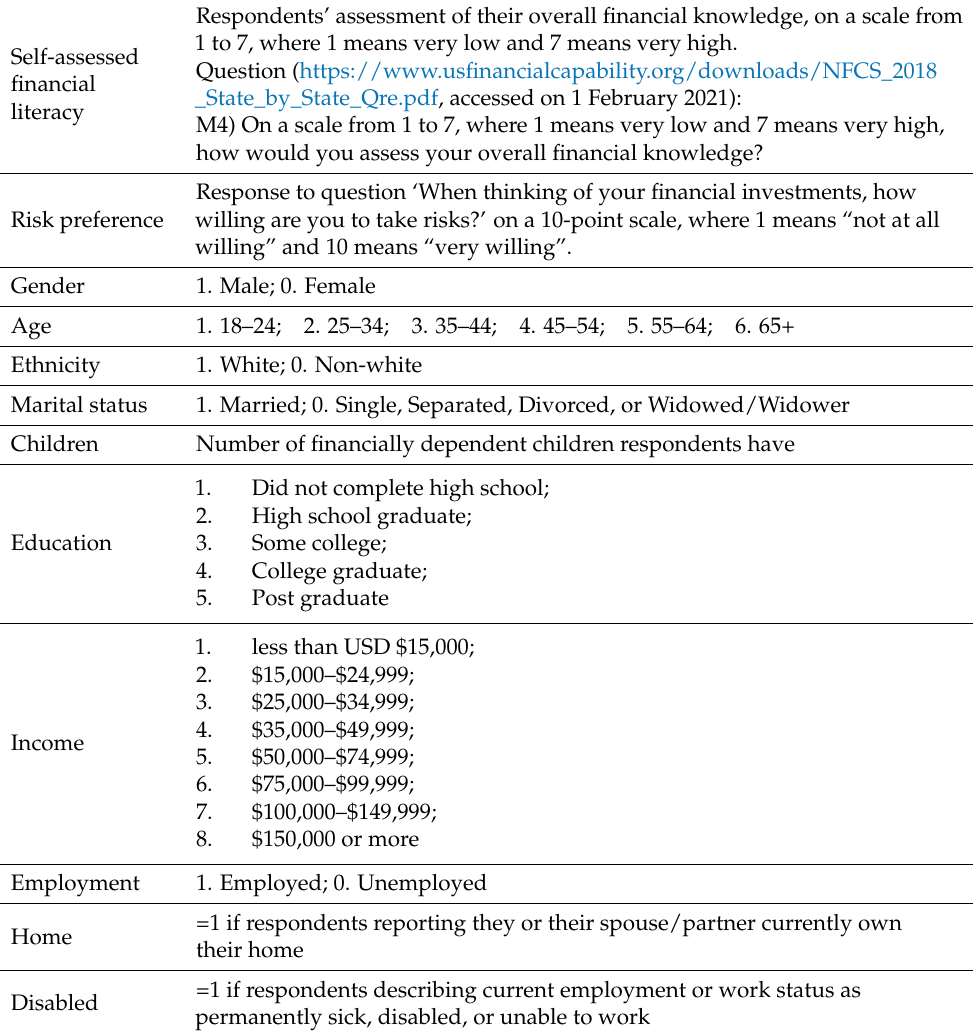
Table A1. Cont. Respondents’ assessment of their overall financial knowledge, on a scale from 1 to 7, where 1 means very low and 7 means very high. Self-assessed financial literacy